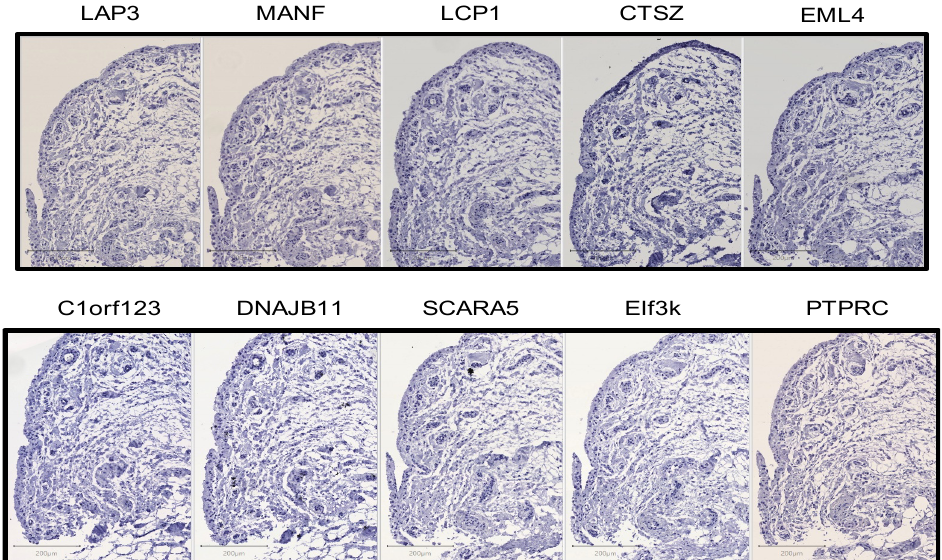
Figure A1. Immunohistochemistry Illustration of Negative Controls Obtained for the 10 Highlighted